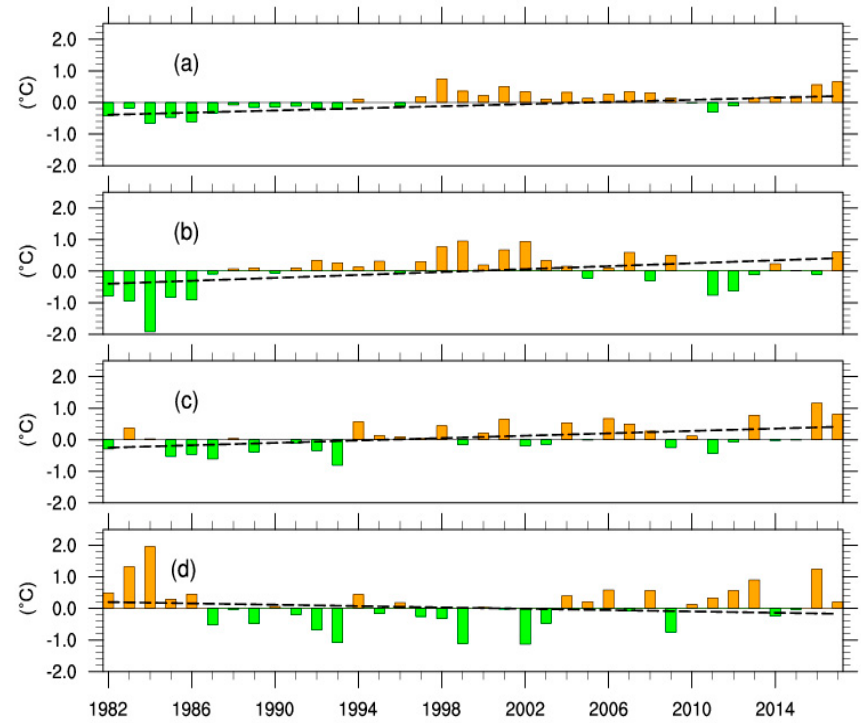
Figure 3. Time series of the regional averaged annual mean SST ( a ), annual minimum SST ( b ), annual maximum SST ( c ) anomalies and AR SST ( d ) in the ECSs from 1982–2017 (Units: °C, 1982– 2011 base period). The black dashed lines are the linear trend lines based on the least squares estimator.